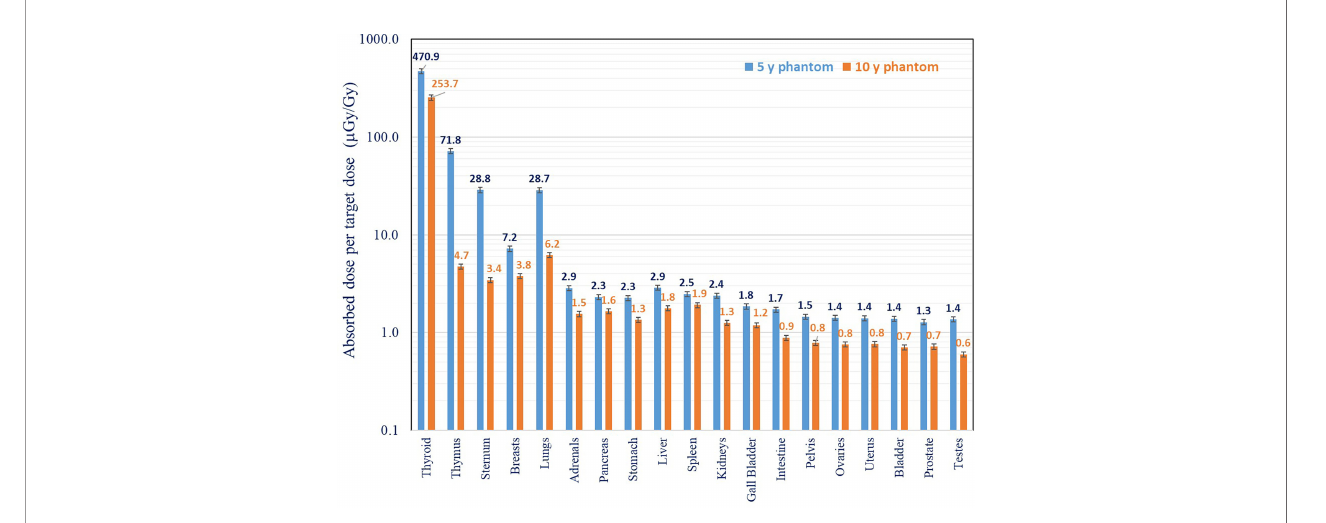
FIGURE 5 | Comparison of non-neutron out-of- fi eld organ doses for 5- and 10-year-old phantom. Measurements were performed with RPL